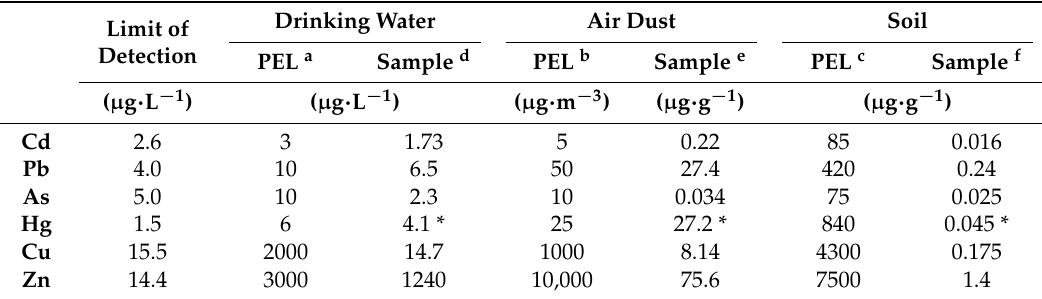
Table 1. Detectable efficiency and the found values of heavy metals in environmental samples using the DEP-On-Go system against quality guidelines from several environmental protection